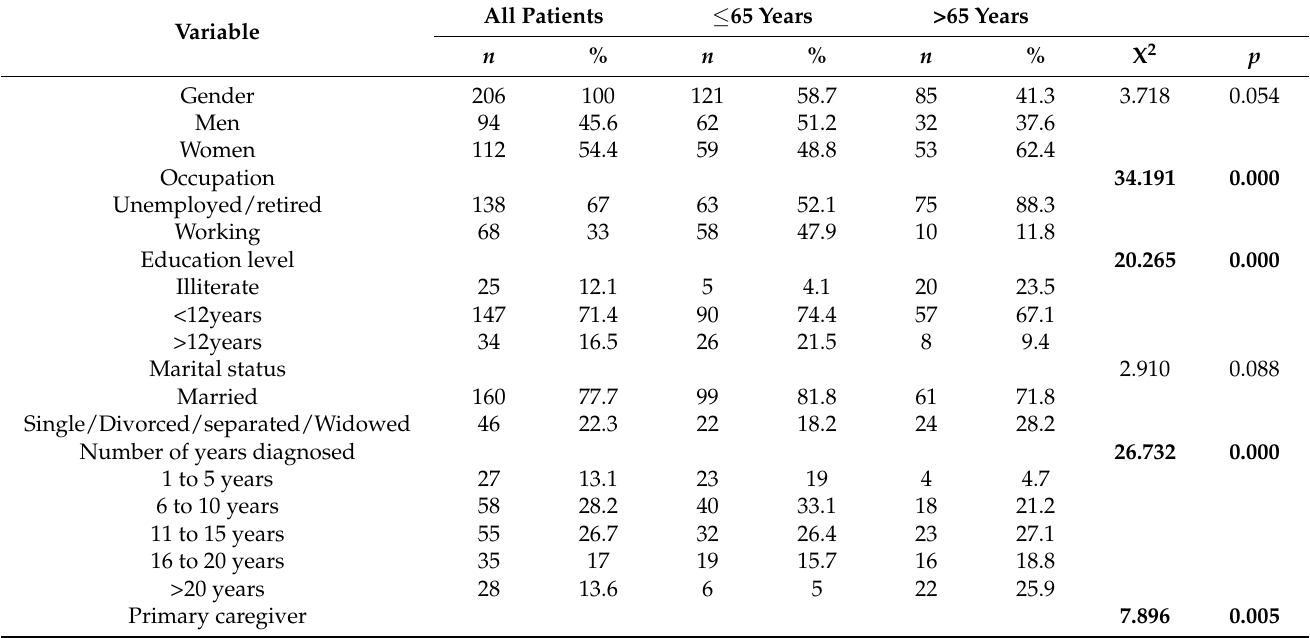
Table 1. Demographic Characteristics and Status of Diabetes Control in Younger ( ≤ 65 Years) and Older (>65 Years) Patients with